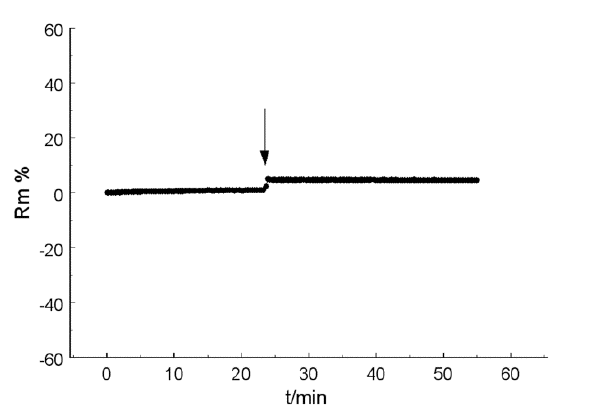
Fig. 7: Plots of the Rm% as a function of time in the absence of yeast. The black arrow indicates the addition of glucose.